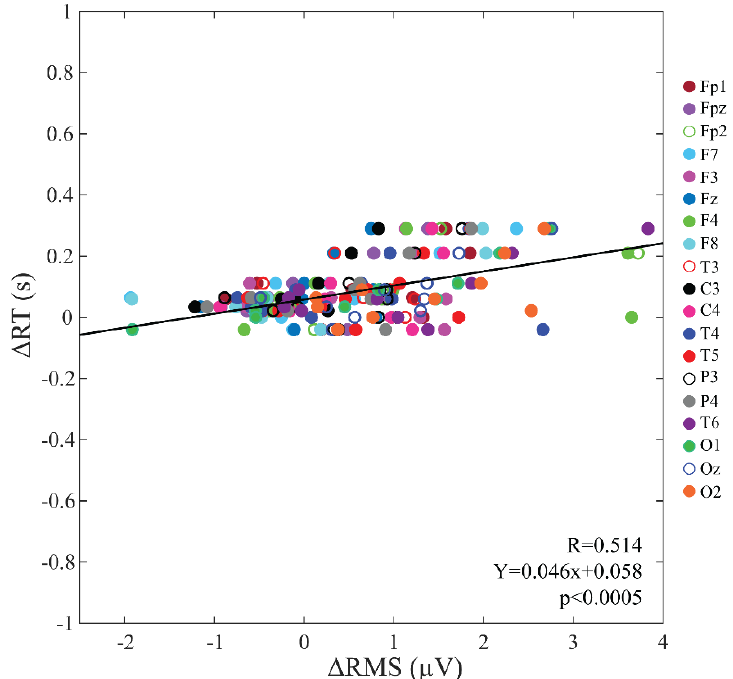
Figure 5. Scatter plot, regression line and corresponding Pearson’s correlation coefficient for the associations between changes induced by SD in the pre-stimulus baseline signal amplitude (RMS) and those in RT. Different electrodes are represented by circles of different colors.